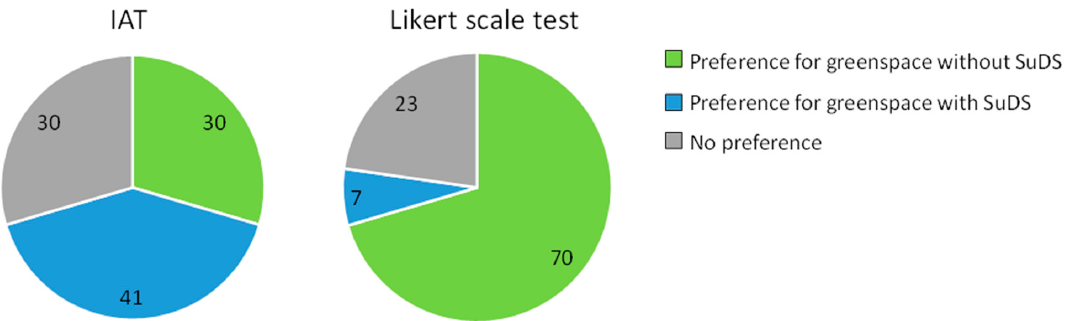
Figure 3. Attitudes towards sustainable drainage systems (SuDS) in public greenspace evaluated via an Implicit Association Tests (IAT) and Likert scale test (explicit measure). Sample population consists of 44 respondents in Bristol, UK, who completed the tests in May–July 2018.